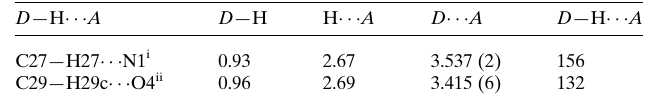
Table 1 Hydrogen-bond geometry (A˚ , (cid:2) ).